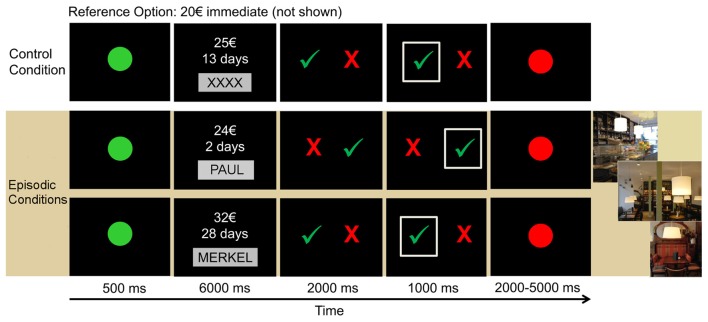
Outline of the paradigm. Each trial started with a green dot, signaling the start of the trial. Then, the delayed reward option was presented for 6 s and participants had to either imagine the event in the café (episodic conditions) or not imagine anything in the control condition. Subsequently, participants had to indicate their choice by selecting the red cross for the immediate reward (20€ that were not shown) or the green check mark for the delayed reward option.